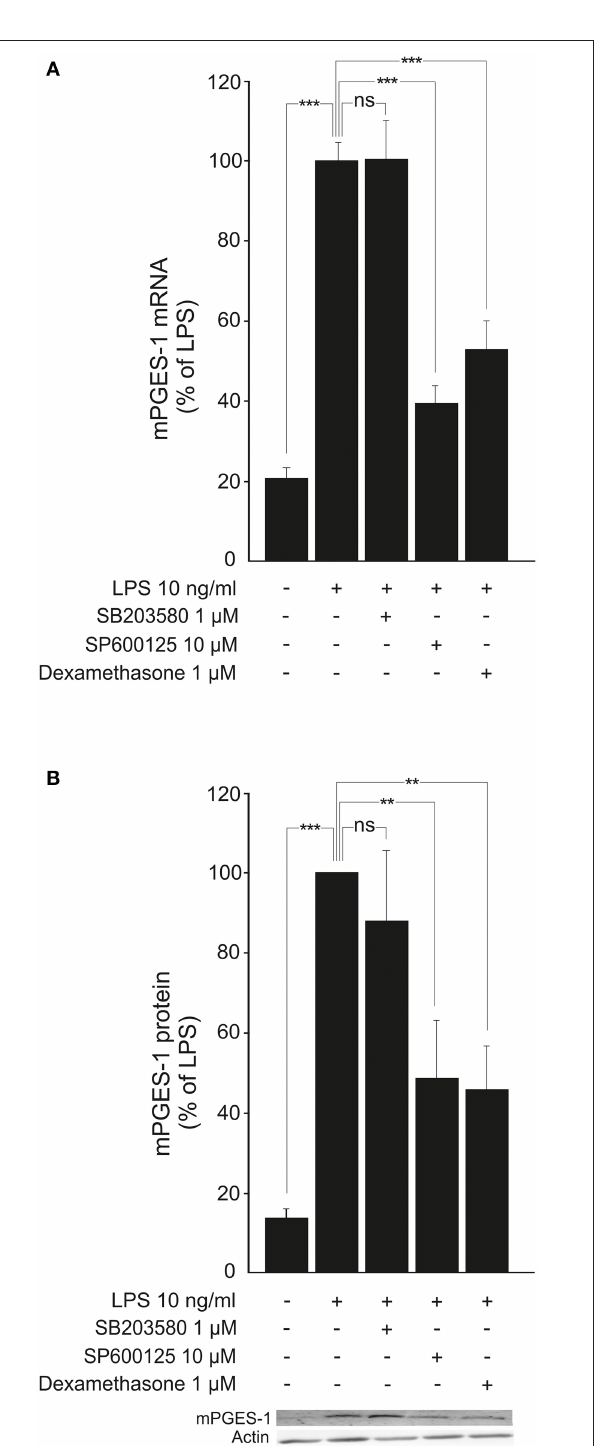
FIGURE 6 | JNK inhibitor SP600125 inhibits the expression of mPGES-1 in activated macrophages. (A) Effects of a JNK inhibitor (SP600125), a p38 inhibitor (SB203580) and dexamethasone on mPGES-1 mRNA production in J774 murine macrophages. Cells were incubated with LPS and the compounds under investigation for 24 h. mPGES-1 mRNA levels were measured by quantitative RT-PCR and normalized against GAPDH